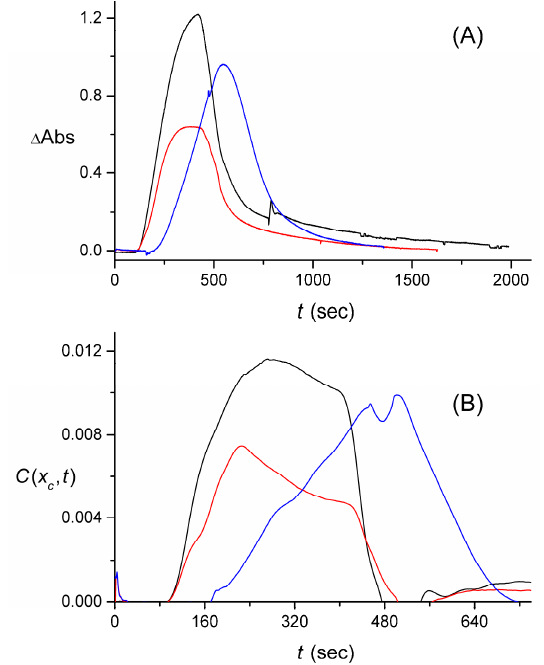
Figure 10. Experimental data measured using a cuvette of a relatively smaller volume. ( A ) Signals, S p t q , generated from rectangular (black) and triangular (blue) pulses without the enzymatic process, and from a rectangular pulse (red) with the enzymatic process ongoing; ( B ) The reconstructed input pulses, C p x c , t q , shown with the same color coding, obtained from the three measured signals, S p t q , after the latter were smoothed out.